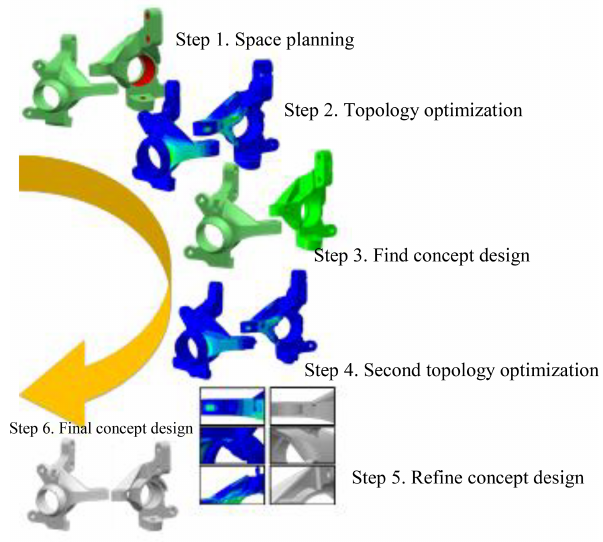
Figure 6. Topology optimization process for steering knuckle.